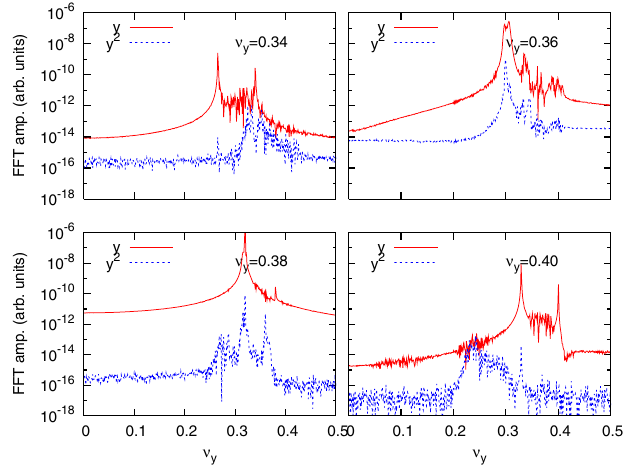
FIG. 12. Luminosity degradation as a function of vertical tune for different values of the beam-beam tune shift per IP (colors) without (top) and with a transverse offset of 0 . 05 σ (bottom). Fig. 13. This coherent instability, which is predicted by theory [26], is caused by mode coupling between the dipole π mode and the quadrupole mode. This interpretation is confirmed by comparing the Fourier transforms of the beam position and beam size. A broad peak of quadrupole mode at 1 − 2 ν y , which is seen in the FFT of the beam size, shifts towards lower frequencies for increasing tune. Two peaks corresponding to the π and σ modes are visible at ν 0 . 34 . Though the σ and quadrupole modes overlap y ¼ here, the beam remains stable. On the other hand, the overlap of the π and quadrupole modes at ν y ¼ 0 . 36 − 0 . 38